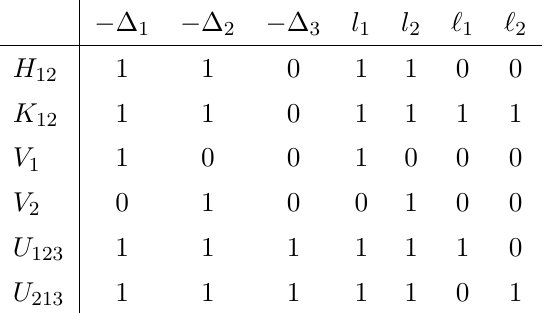
of t ( X ) . Negative powers of X are not possible either, as these would produce the tensor structure H in the denominator, which itself contains both Z and Z but cannot be 12 1 2 compensated by the prefactor Ω that does not contain H . In conclusion, t ( X ) must be a 12 polynomial of order up to n = min ( l ) if n − ‘ , l − ‘ ≥ 0 , and it must vanish if n < 0 t 1 1 2 1 t t